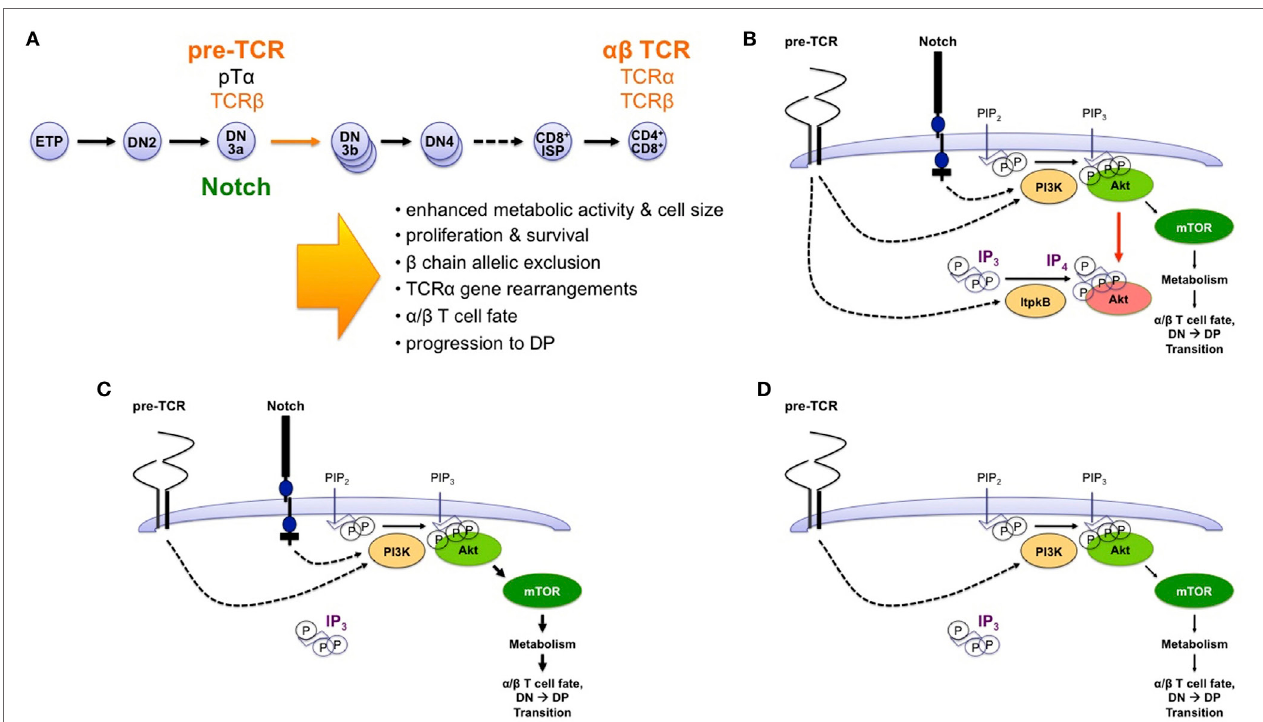
FigURe 7 | Non-canonical antagonism of phosphoinositide 3-kinase (PI3K) by Itpkb delays thymocyte β -selection and renders it Notch dependent. (A) T cells develop in the thymus from HSC and CLP-derived early thymocyte progenitors (ETPs) through several successive CD4 − CD8 − “double-negative” stages (DN2-DN4) and a CD8 + immature single-positive (ISP) stage into CD4 + CD8 + double-positive (DP) thymocytes (93, 94). DP cells then undergo positive and negative selection to mature into CD4 + or CD8 + T cells. At the DN3a stage, expression of a pre-T cell receptor (TCR) composed of an invariant pre-TCR α (pT α ) chain and a fully rearranged TCR β chain triggers metabolic activation, proliferation, survival, β chain allelic exclusion, the initiation of TCR α chain somatic gene rearrangements, acquisition of the α / β T cell fate, and developmental progression to the DP stage. DP thymocytes express a mature TCR composed of fully rearranged α and β chains. The DN3-to-DP transition requires pre-TCR and costimulatory Notch signals. This process is termed β -selection, because it allows only DN3 cells expressing a functional TCR β chain to survive and mature. (B) Based on studies in Itpkb − / − mice, we recently proposed a model in which pre-TCR and Notch signaling both activate PI3K to produce PIP 3 in DN3 cells. PIP 3 then recruits and activates Akt to increase glucose metabolism via the Akt/mammalian or mechanistic target of rapamycin (mTOR) pathway. This is required for β -selection. However, pre-TCR signaling also activates Itpkb to produce IP 4 , which competes with PIP 3 for Akt pleckstrin homology domain binding and limits Akt recruitment and signaling in pre-TCR expressing DN3 cells. By limiting downstream glucose metabolism, this “IP 4 brake” delays the kinetics of β -selection and renders this process dependent on Notch costimulation (27). (C) Without Itpkb, IP 4 no more dampens Akt activation. In the presence of Notch signals, Akt is now hyperactivated and causes an accelerated DN3-to-DP cell differentiation (indicated by bold arrows). (D) In absence of Itpkb, pre-TCR signaling alone sufficiently activates Akt/mTOR to trigger DP cell development without Notch engagement